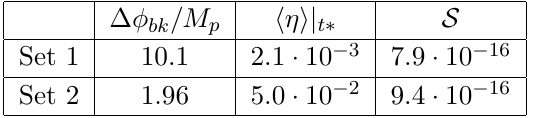
Table 8 . The e(cid:11)ects of backreaction for the two parameter sets.